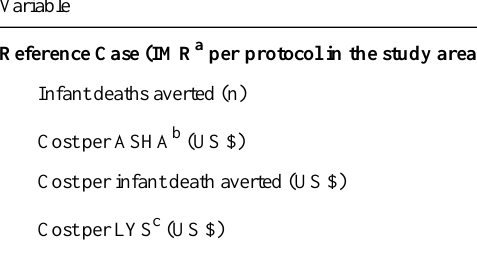
Table 4. Sensitivity analysis under different scenarios.